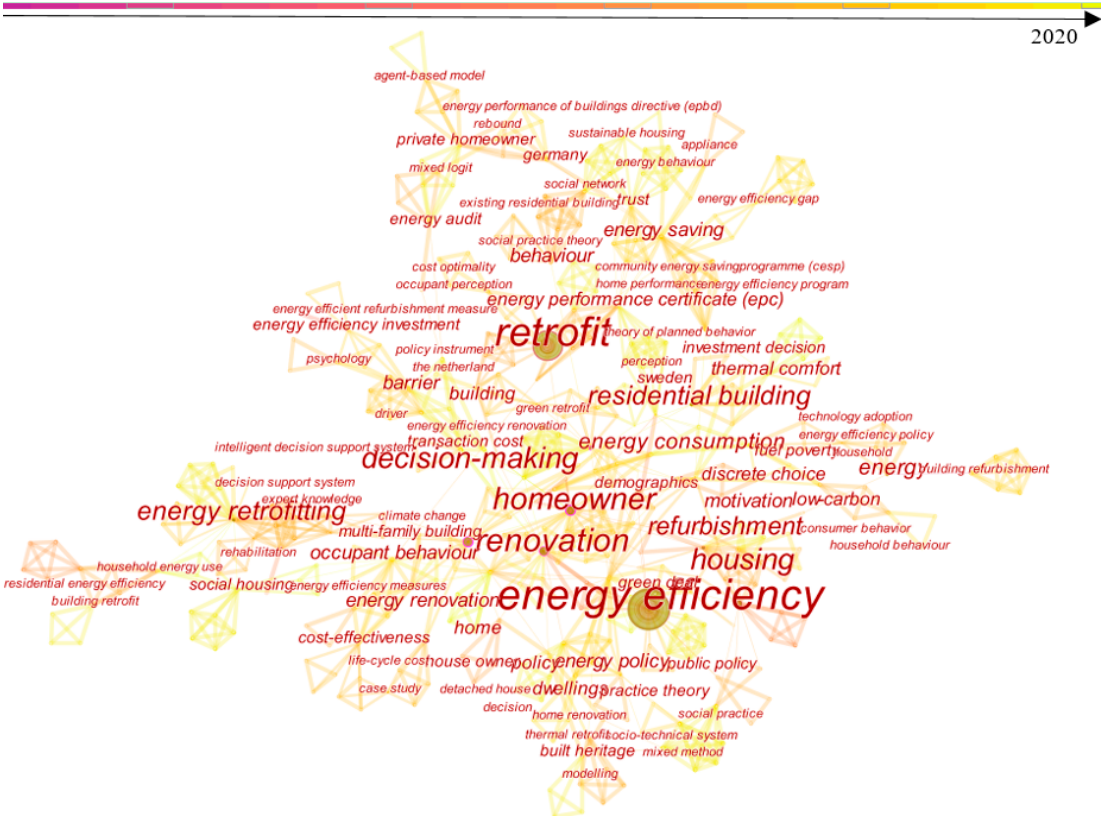
Figure 2. Keywords co-occurrence network.